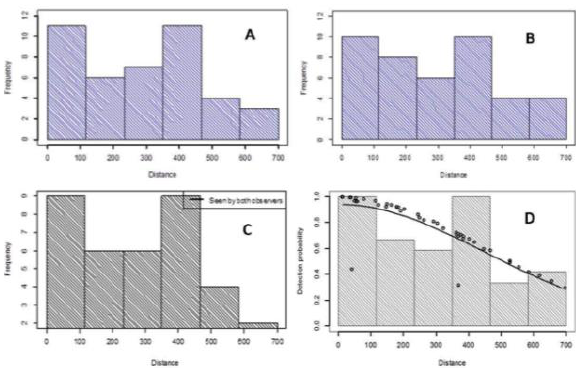
Figure 14. Scaled histograms of perpendicular distances and the predicted detection probability functions for white-beaked dolphin groups. A) Front observers, B) rear observers, C) both observers and D) pooled detections with sightings fitted to a half-normal model where each observation prediction is shown as a circle. Distance is measured in meters from the line directly below the aircraft. Detection of other species Bottlenose whales ( Hyperoodon ampullatus ) (group size 1-4)